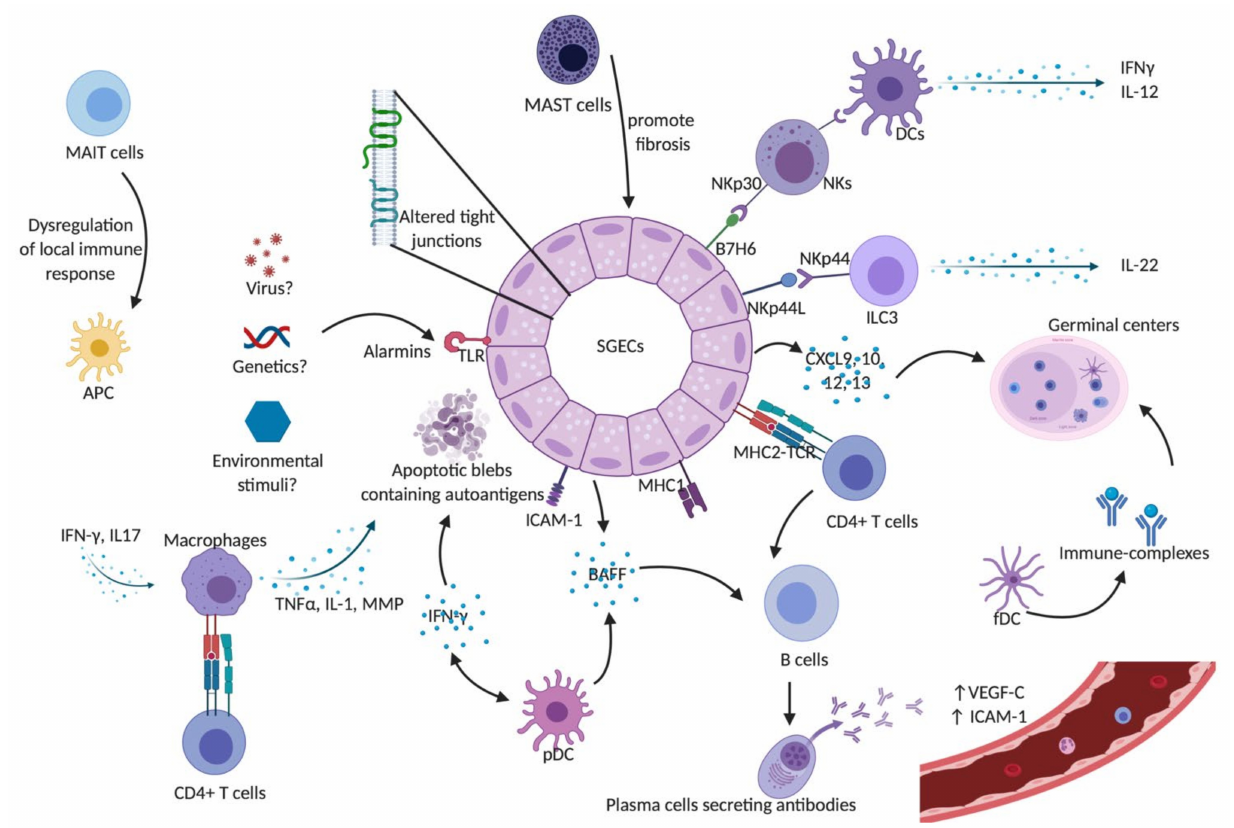
Figure 1. Innate immunity in Sjögren’s syndrome. SGECs constitute the main target of auto-immunity in pSS, described as an autoimmune epithelitis. SGECs exhibit a subverted architecture mainly characterized by altered tight junctions. In genetic susceptible subjects, environmental stimuli such as viruses may trigger salivary gland epithelial cells (SGECs) through TLR activation. Activated SGECs secrete the BAFF that promotes activation and maturation of B cells. SGECs also produce chemokines such as CXCR9, 10, 11, and 12 that attract immune cells and contribute to the formation of germinal centers. Activated SGECs have the ability to act as non-professional antigen-presenting cells by expressing MHC-I, (HLA-ABC) and MHC-II (HLA-DR), adhesion molecules such as ICAM1 allowing them to activate T cells. TLR activation also contributes to SGEC apoptosis, releasing autoantigens that drive autoimmunity in pSS. Activated macrophages produce inflammatory cytokines such as IL-1, TNF α , and MMPs leading to epithelial cell damage. They can also act as antigenic peptide presenting cells through their MHC-II and interact with antigen-specific CD4+ T cells. pDCs lead to the production of type I IFN that acts through autocrine and paracrine circuits feeding a continuous reinforcing inflammatory loop. It also induces the production of BAFF, production contributing to the activation of B cells into plasma cells. fDCs play an essential part in the structure of ectopic germinal centers and retain on their surface immune-complexes, formed by antigen-antibody-complement. Mast cells contribute to the fibrosis and fatty infiltration of salivary glands (SGs). The aberrant phenotype of MAIT cells in pSS patients may lead to the dysregulation of the local immune responses, which would trigger local damage in SGs and auto-immunity. NK cells express the NKp30 receptor that is recognized by DCs and lead to the production of Th1 cytokines such as IFN- γ and IL-12. SGECs express B7-H6, the ligand for NKp30. Taken together, this may explain the hyperactivity of NK cells and the cross-talk with SGECs and DCs that lead to a subsequent activation of innate and adaptive immunity. A subset of ILC3 was found to be a major source of IL-22 in SGECs. Abbreviations: APC: Antigen presenting cells; BAFF: B-cell activating factor; CXCL9: C-X-C motif chemokine type